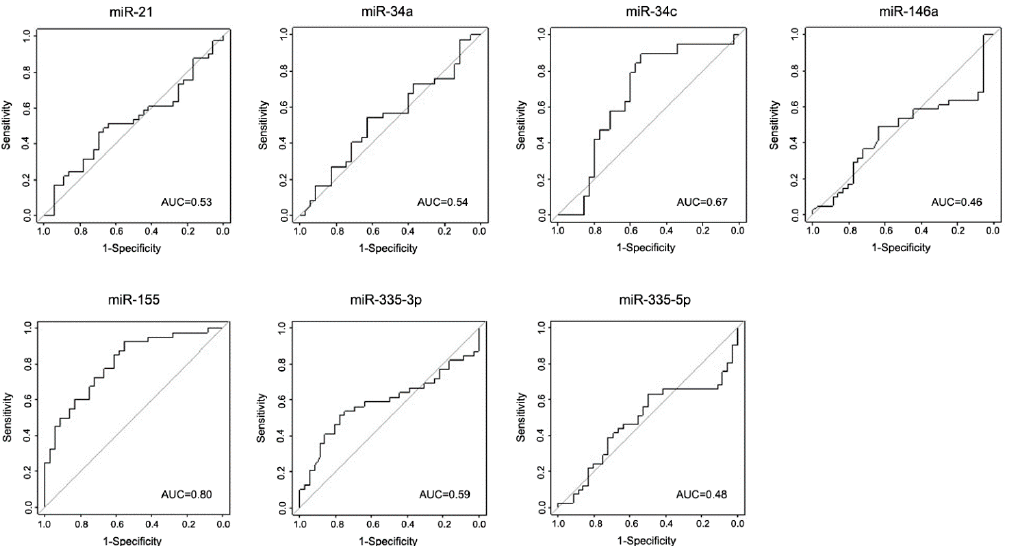
Figure 7. Receiver operating characteristic (ROC) curves of miRNAs in discovery and validation cohorts, discriminating between iPD and LRRK2-PD patients. The true positive rate (sensitivity %) is plotted as a function of the false positive rate (100%—specificity) for the seven miRNAs individually. Area under the curve (AUC) values are indicated in each plot.